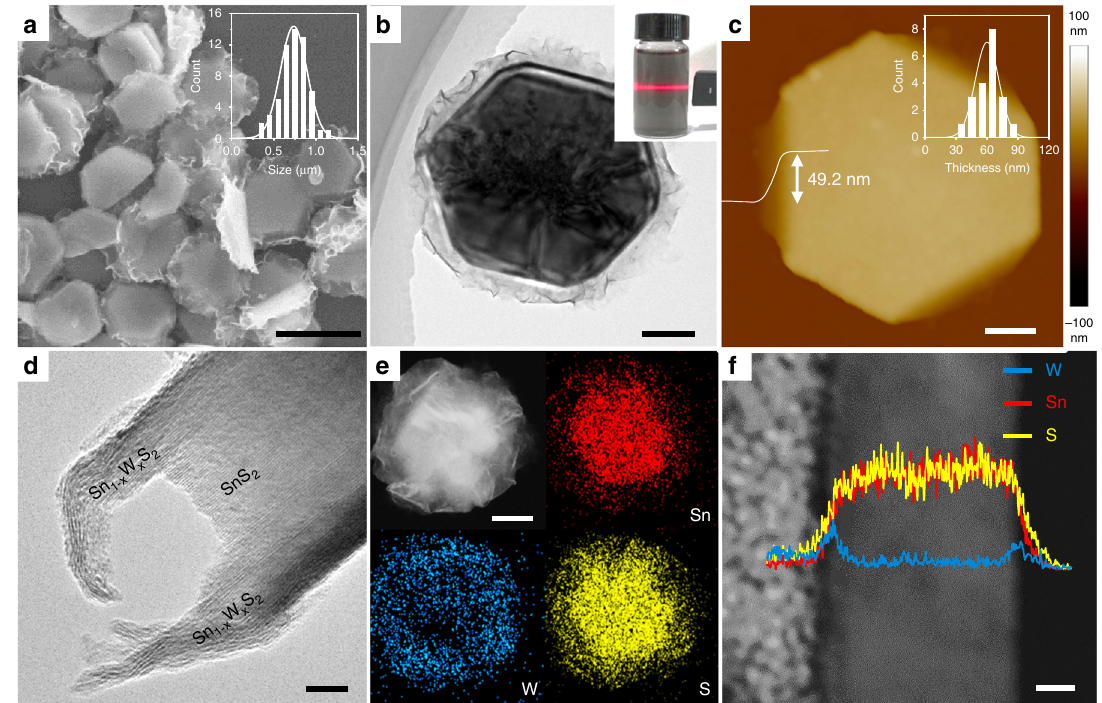
Fig. 1 Morphology and composition analyses of Sn 0.5 W 0.5 S 2 /SnS 2 heterostructures. a SEM image of as-prepared Sn 1 – x W x S 2 /SnS 2 heterostructures (scale bar, 1 μ m). Inset: size distribution of Sn 1 – x W x S 2 /SnS 2 heterstructures. b Top-view TEM image of typical Sn 1 – x W x S 2 /SnS 2 heterostructures (scale bar,